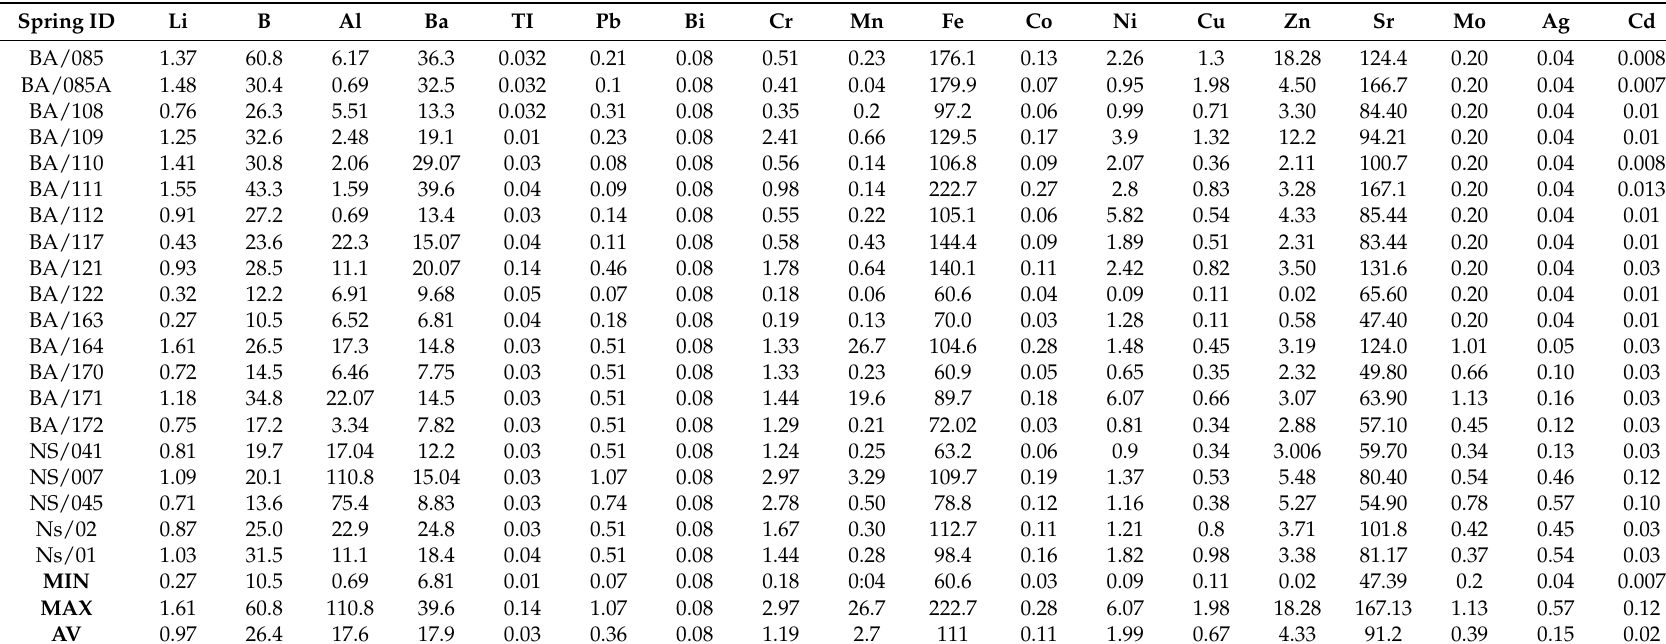
Table 5. Trace element compositions of spring water samples (in µ